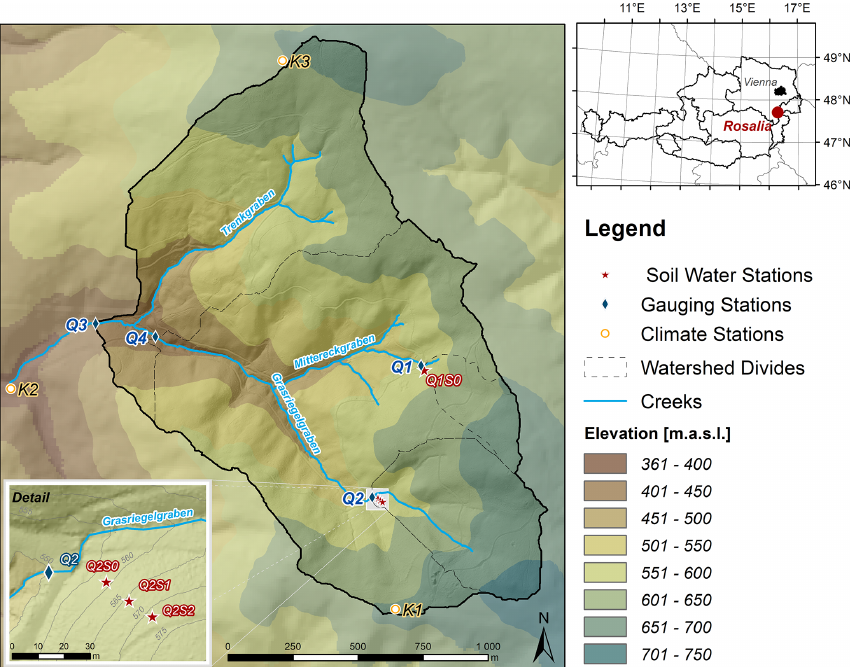
Figure 1. Map of the watersheds and the monitoring network (DEM source: Land Niederösterreich – http://data.noe.gv.at, last access: 29 June 2021).